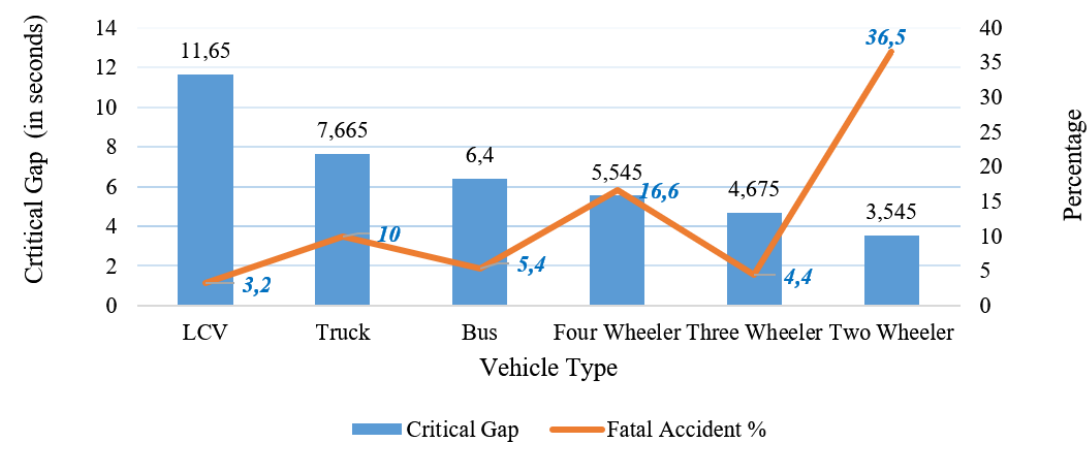
Figure 5: Comparison of critical gap values and fatal accident for different road user categories